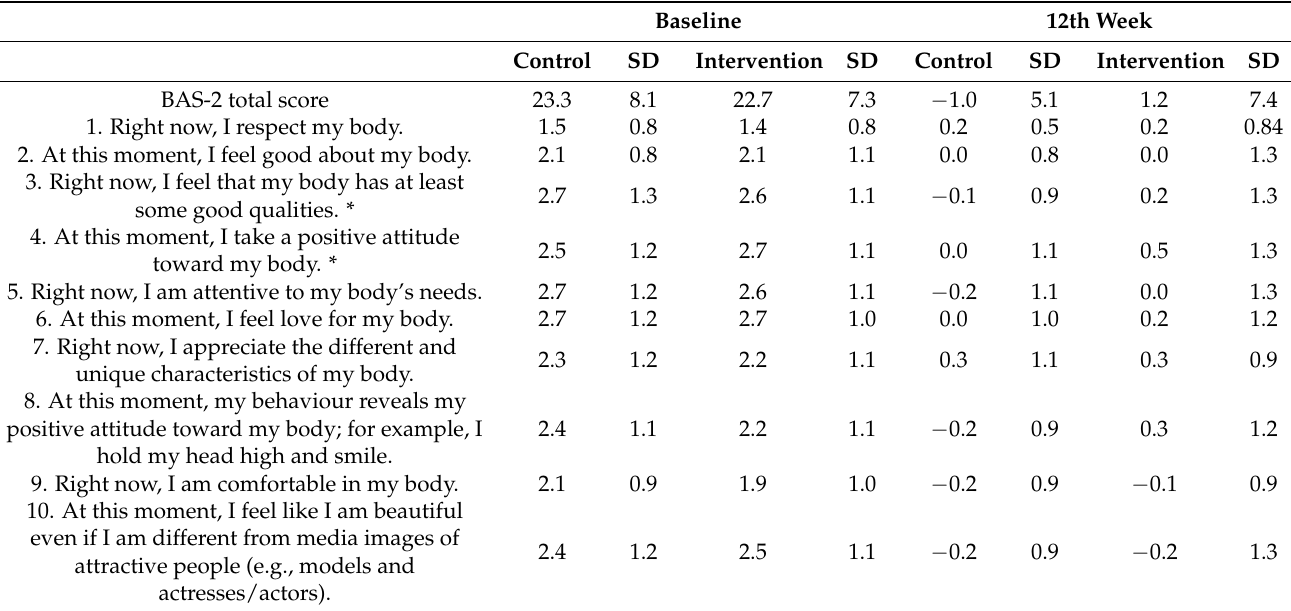
Table 3. Scores on the Body Appreciation Scale-2 at baseline and the 12th